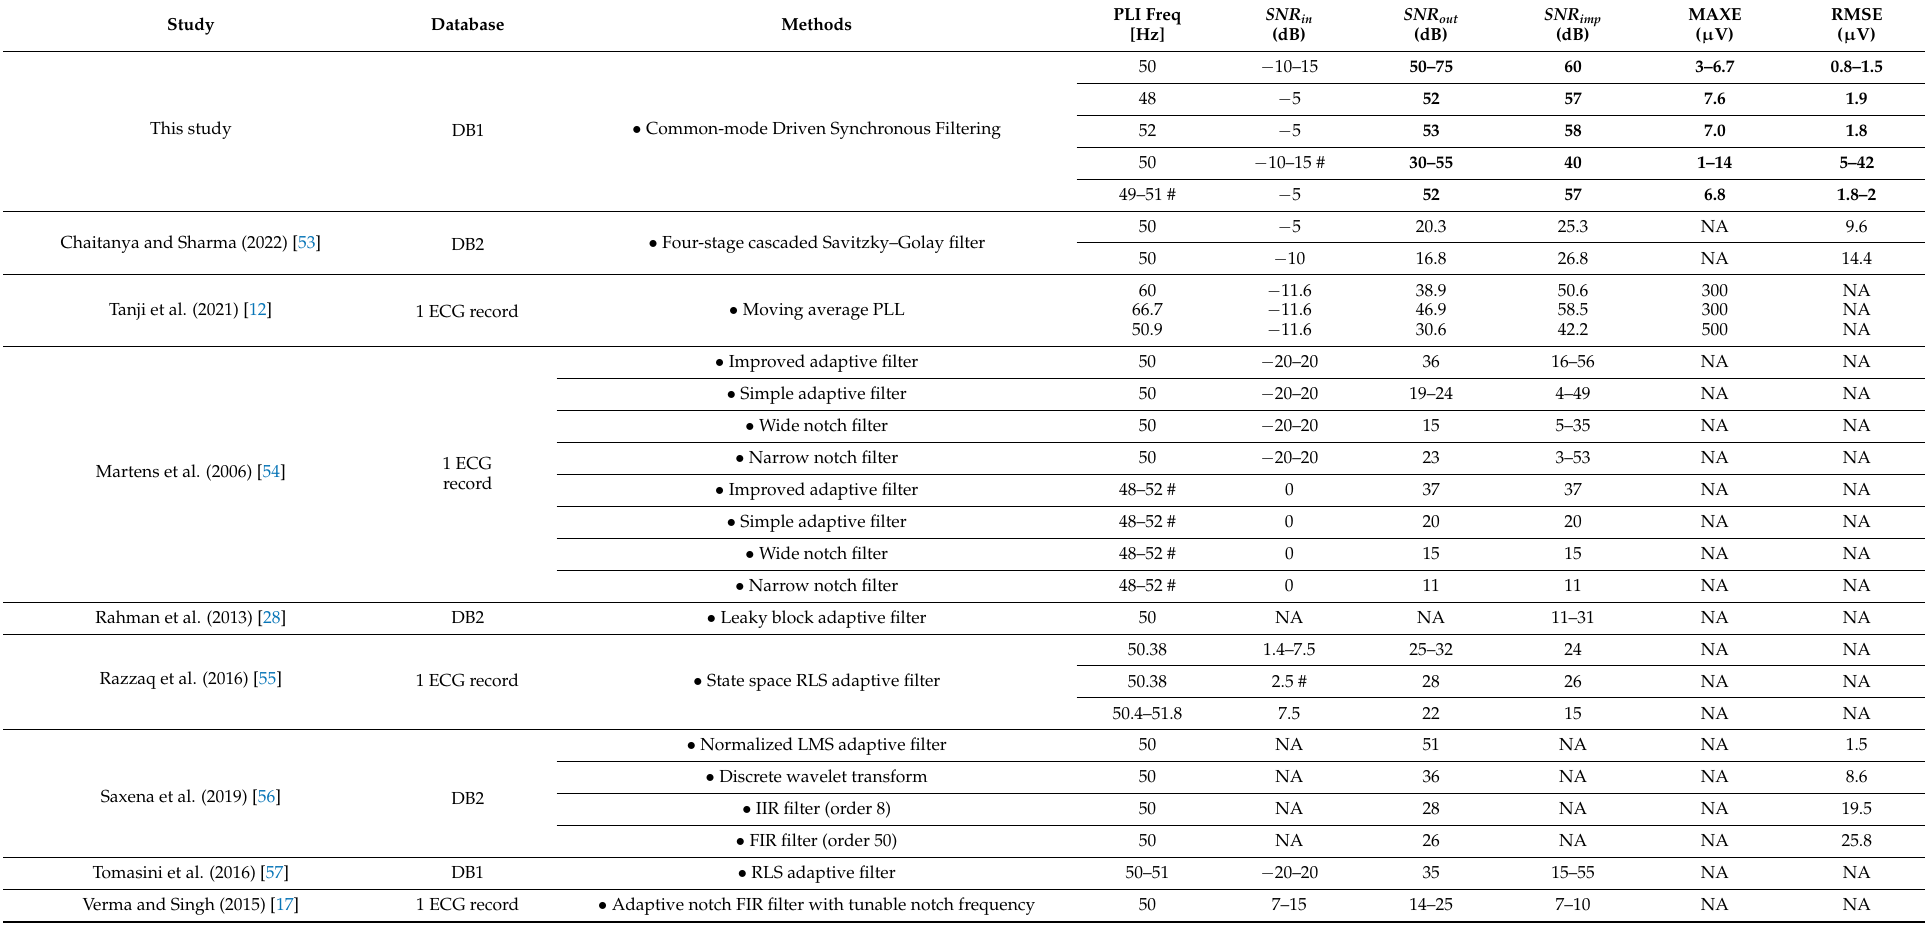
Table 4. Comparative study with other published papers on PLI filtering in ECG found to provide a comprehensive numerical evaluation of the filer outputs by at least one of the performance metrics calculated in this study. The performances are listed as reported in original articles, representing mean values if several records from a test database were evaluated, otherwise representing a single measurement from one ECG